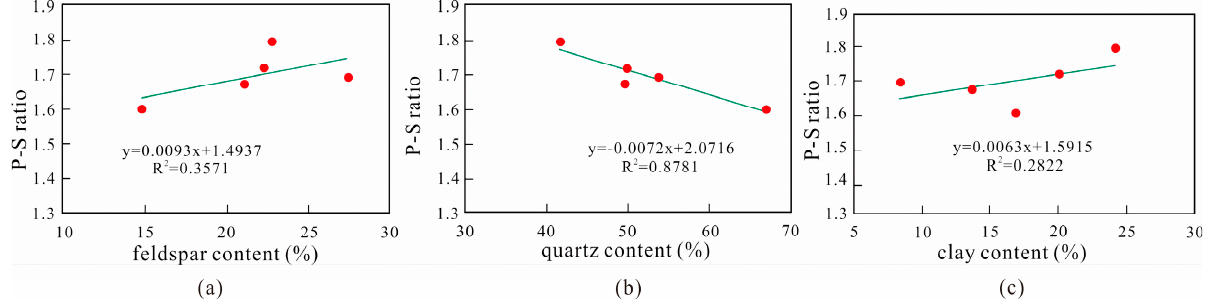
Figure 7. Relationship curves between feldspar content, quartz content, clay content and aspect ratio.